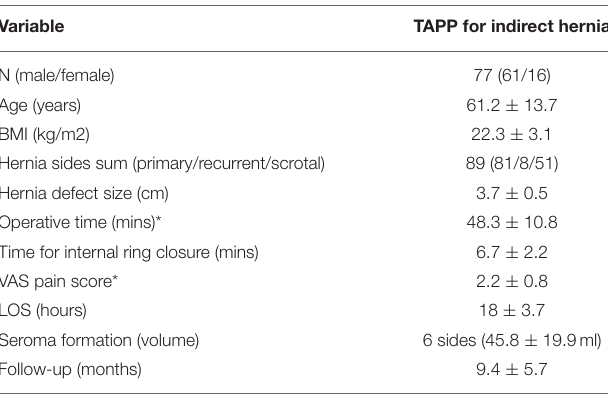
TABLE 1 | Patients’ general demographics and perioperative data.